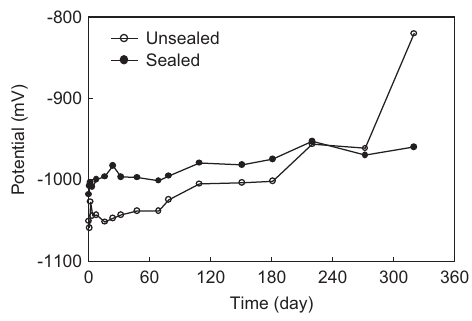
Figure 1 Change in potentials of ZAZA coatings with time.